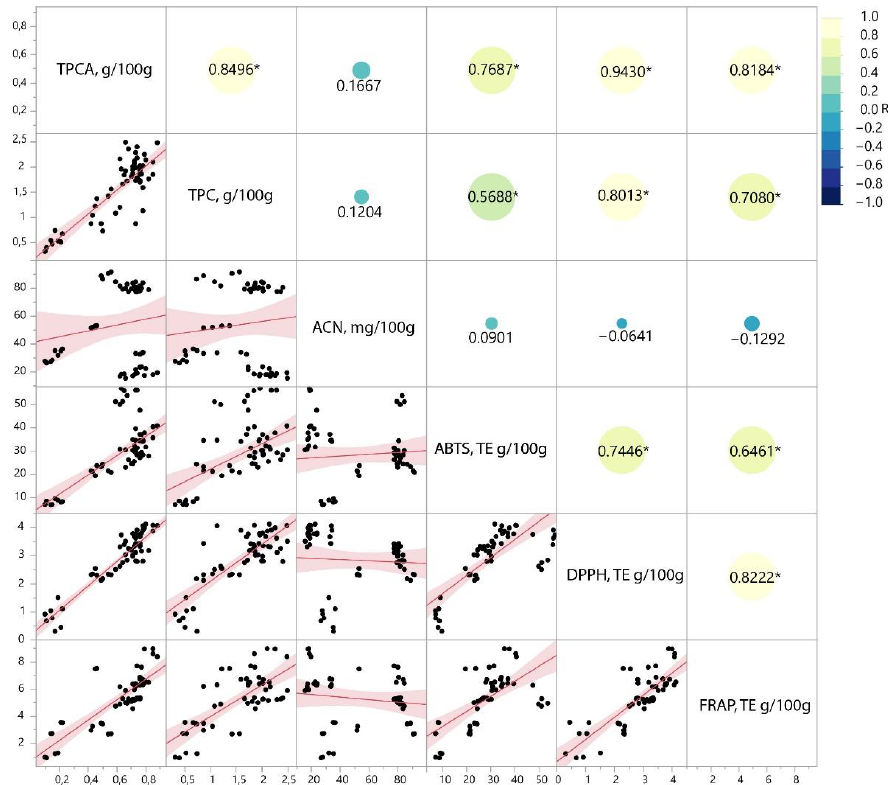
Figure 4. Multivariate correlation analysis of total group parameters (TPCA, ACN, TPC) and the measured antioxidative activity (DPPH, ABTS, FRAP) of extract fractions. The asterisk (*) next to the correlation coefficient R represents a statistically significant correlation (pairwise correlations, α = 0.05 , n = 76 for each parameter).